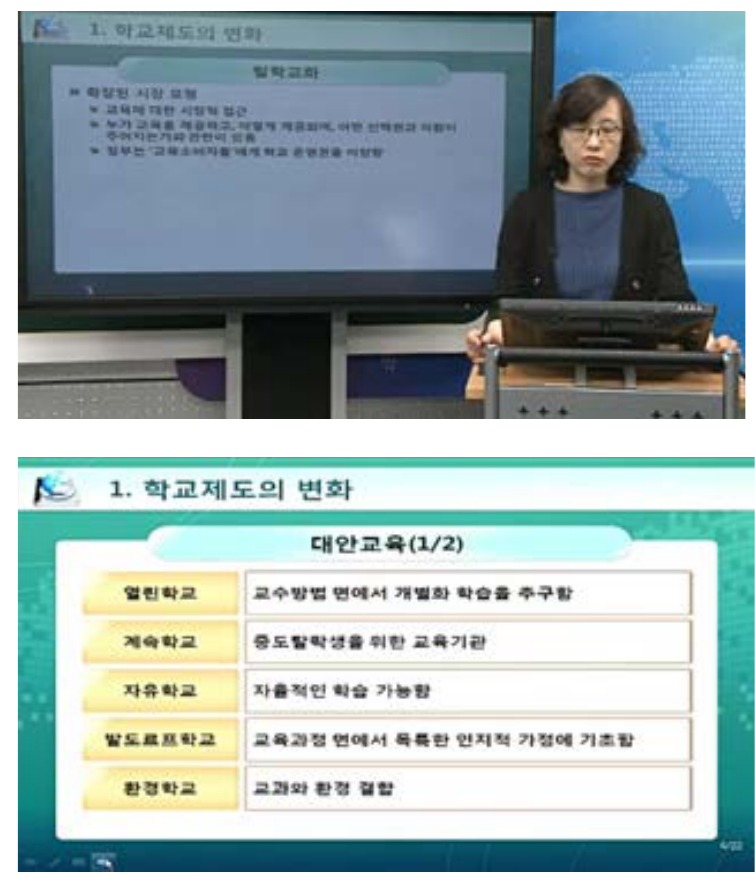
Figure 1 . Screenshot of the video lecture on mobile